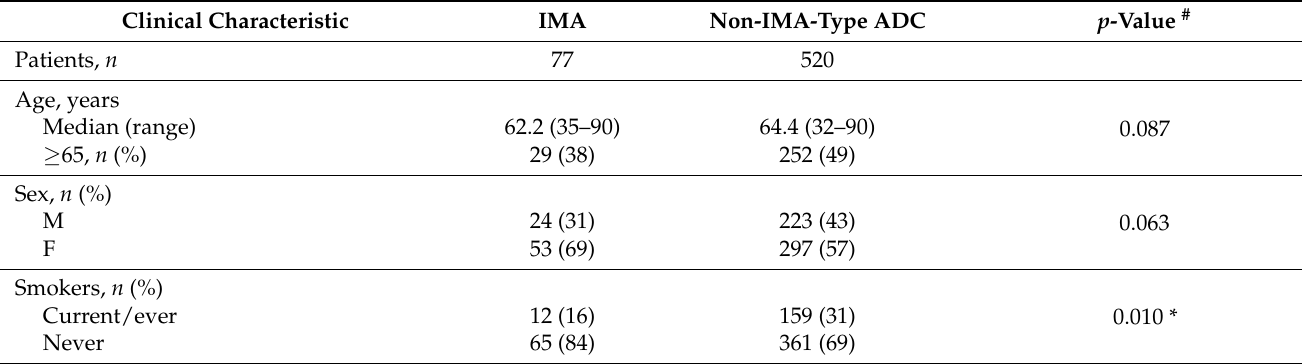
Table 1. Clinical characteristics of patients with pulmonary invasive mucinous adenocarcinoma (IMA) ( n = 77) or non-IMA- type adenocarcinoma ( n =